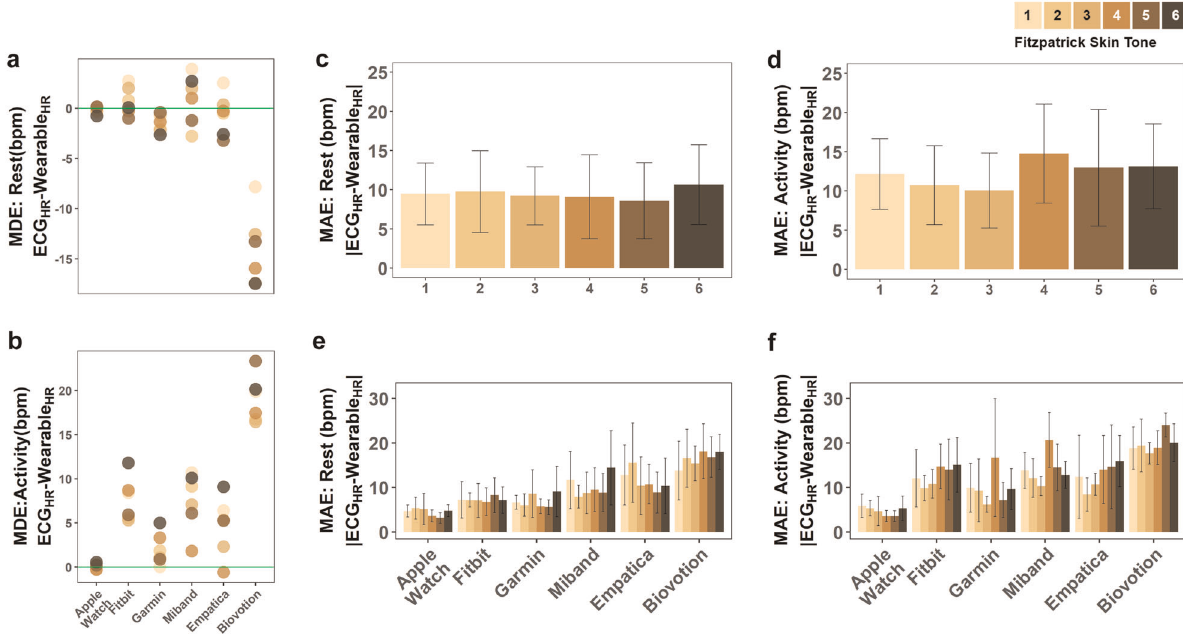
Fig. 2 Error in heart rate across skin tones and devices at rest and during activity. Mean error in heart rate (bpm) across skin tones and devices at a rest and b during physical activity. The green horizontal line represents no error (no difference from the true measurement of HR from ECG). Mean absolute error in heart rate (bpm) across skin tones and devices at c rest and d during physical activity. Error is calculated as the difference between the ECG and wearable reported heart rate at every simultaneous measurement. Fitzpatrick skin tones 1 – 6 are represented with an approximately equal number of participants in each skin tone. Error bars represent the 95% con fi dence interval. Mean absolute error across devices and across skin tones at rest ( e ) and during activity ( f ). Error bars represent the 95% con fi dence